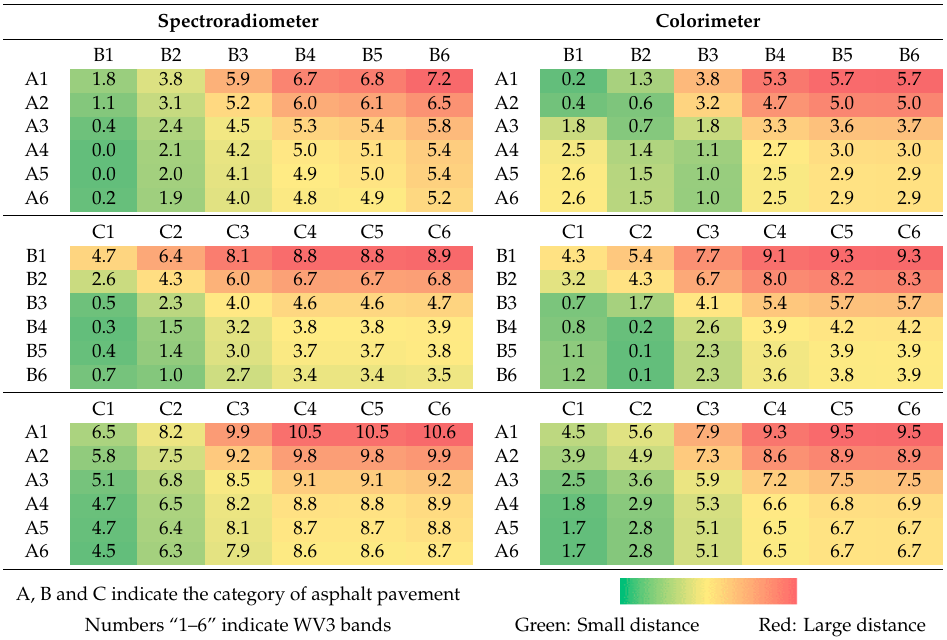
Red: Large distance Red: Large Green: Small distance distance